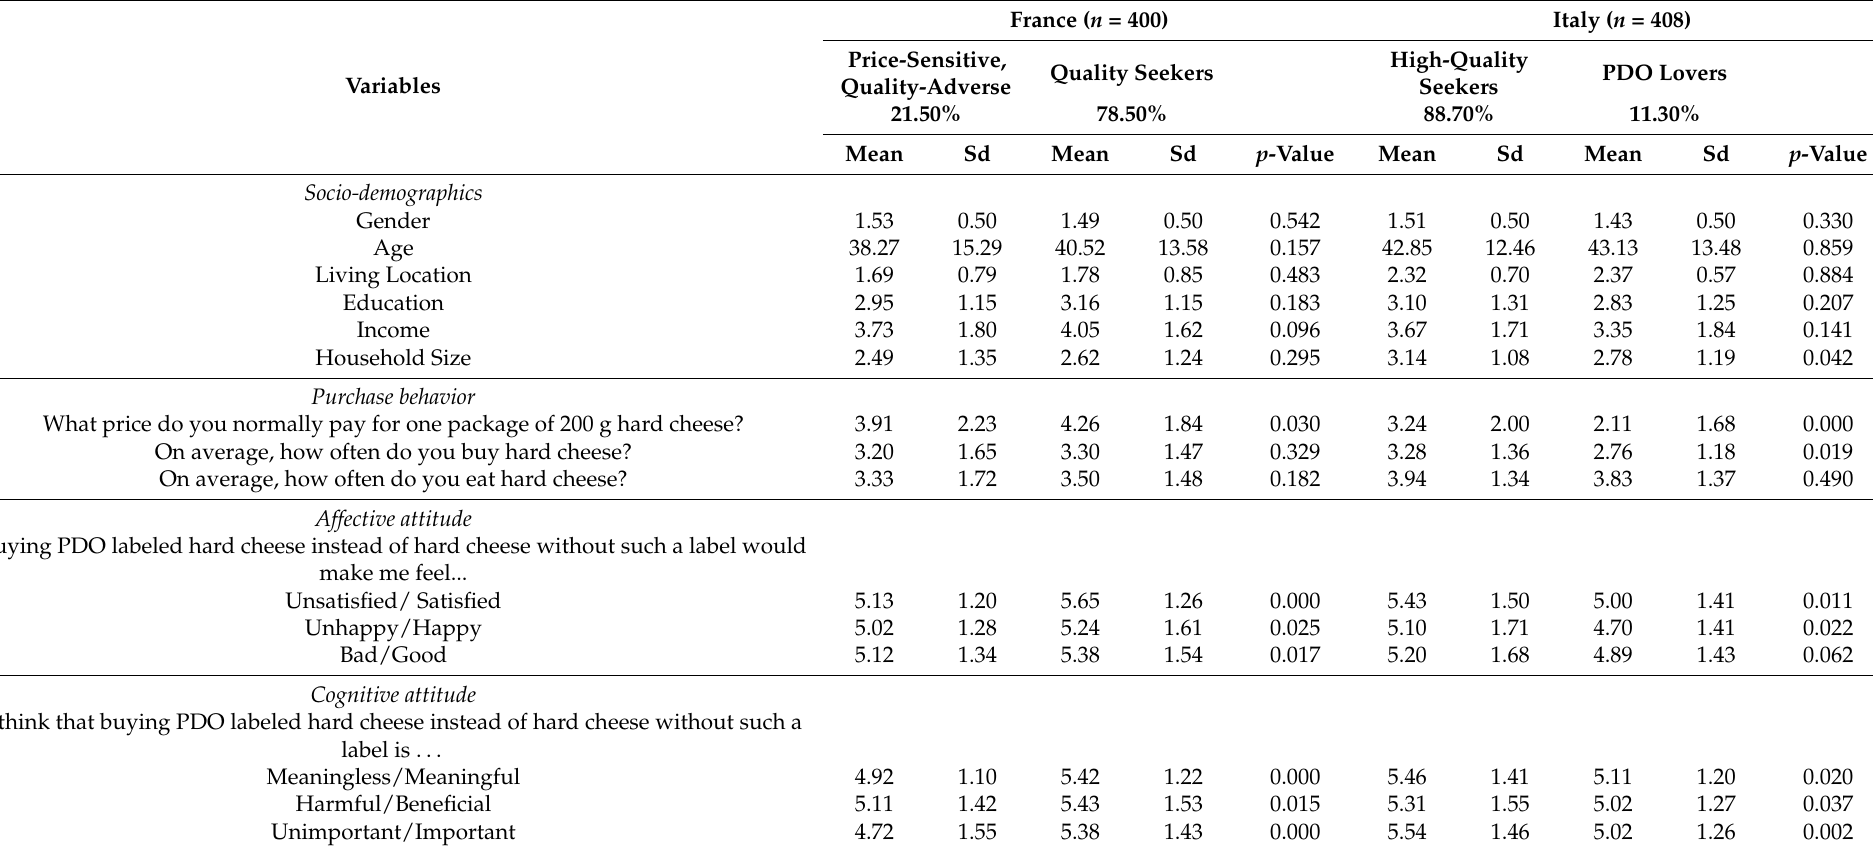
Table A1. Latent class analysis (LCA) models: participants’ characteristics, attitude, purchase behavior differences between classes in France and Italy (independent- samples Mann–Whitney U